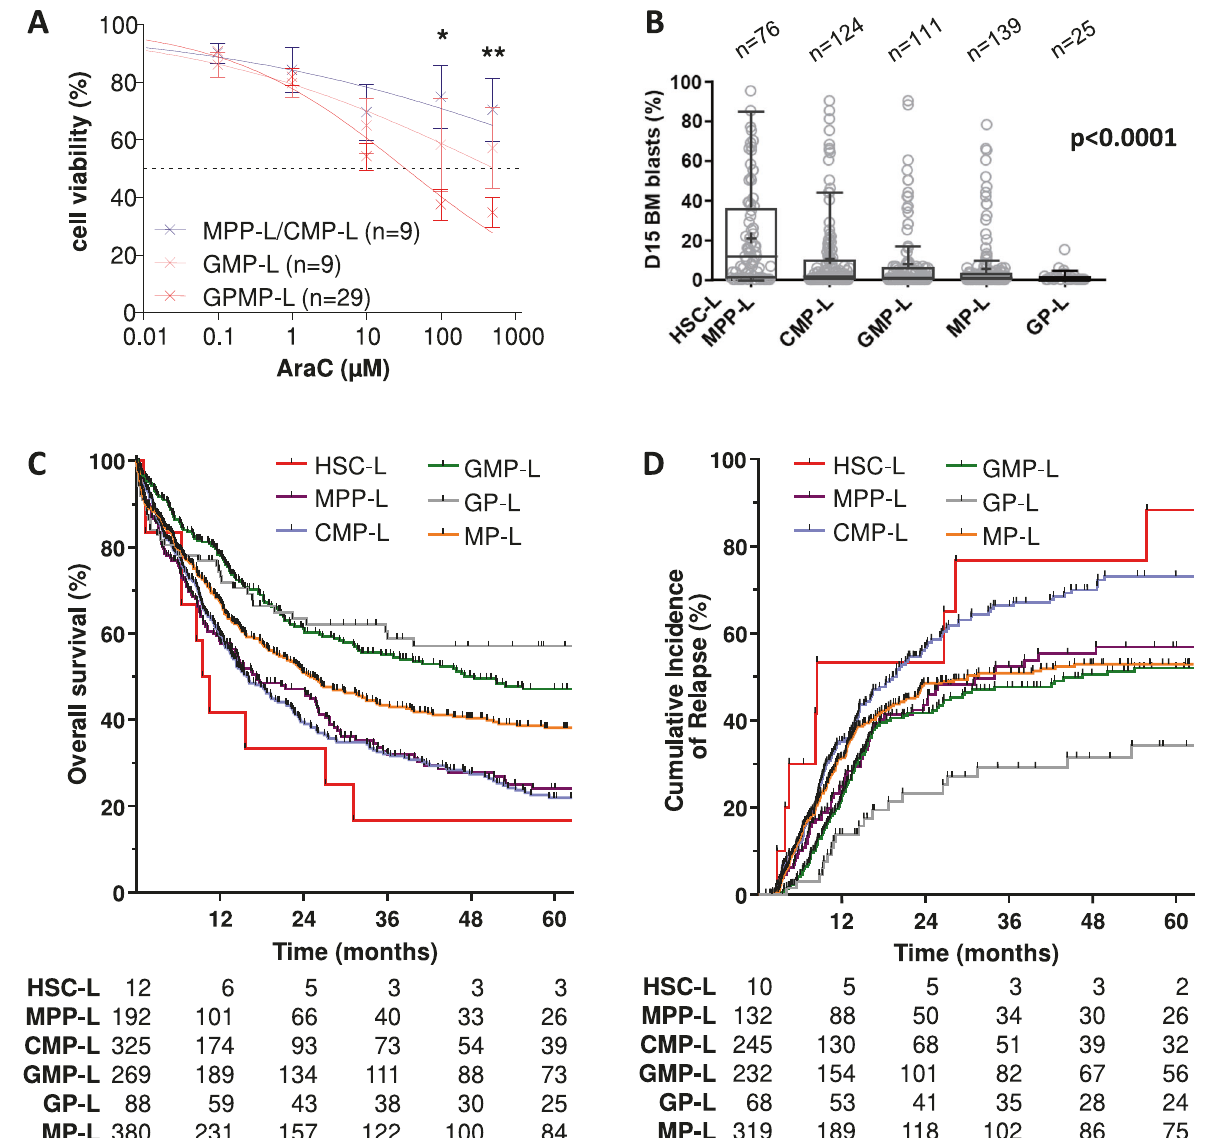
Fig. 6 Response to chemotherapy according to the SLA. A In vitro testing of cytarabine (AraC) activity in 47 AML samples. B Early chemosensitivity according to SLA was evaluated in patients by measuring the percentage of residual blasts in bone marrow at day 15 of induction chemotherapy ( n = 475). C Prognostic impact of SLA on overall survival for patients from TUH cohort treated with intensive chemotherapy ( n = 1266). See Table S2 for multivariate analysis results. D Prognostic impact of SLA on overall survival for younger patients (<60 years) from TUH cohort treated with intensive chemotherapy ( n =